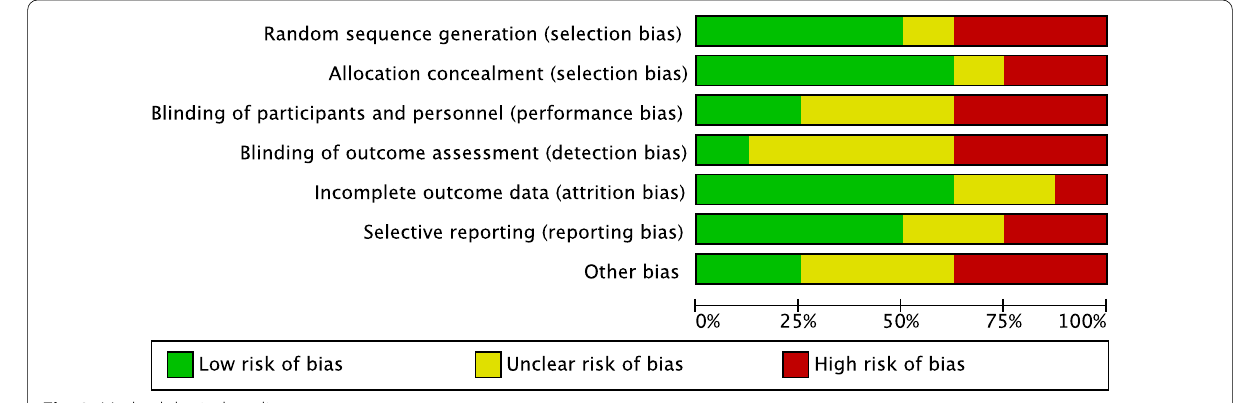
Fig. 2 Methodological quality assessment